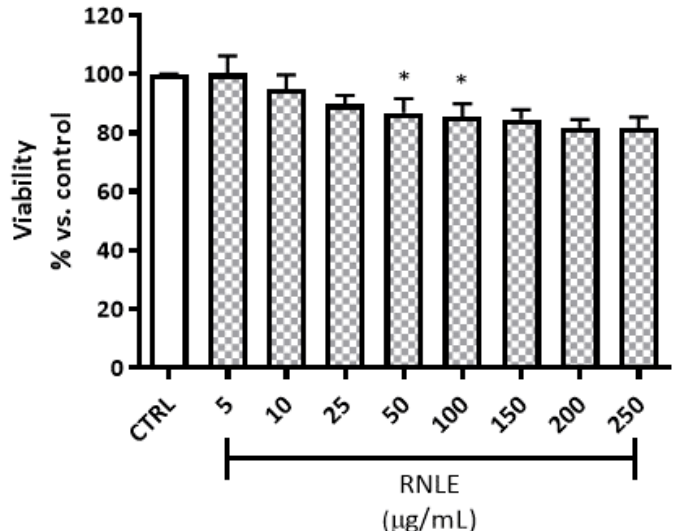
Figure A2. Effect of 24 h RNLE treatment (5–250 µg/mL) on HaCaT cell viability, as measured with LDH assay; * p < 0.05 vs. stimulus.